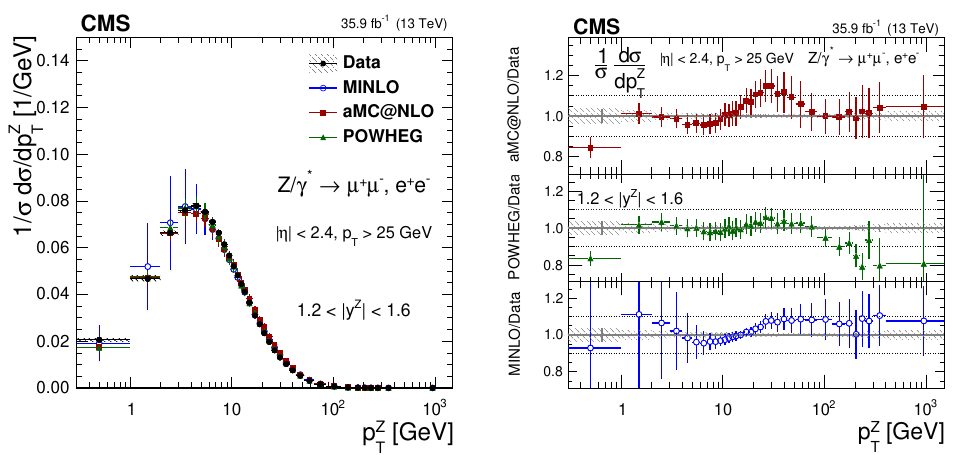
Figure 18 . The measured normalized cross sections (left) in bins of p Z region. The ratios of the predictions to the data are also shown (right). The shaded bands around the data points (black) correspond to the total experimental uncertainty. The measurement is compared to the predictions with MadGraph 5 a mc@nlo (square red markers), powheg (green triangles), and powheg - MINLO (blue circles). The error bands around the predictions correspond to the combined statistical, PDF, and scale uncertainties.